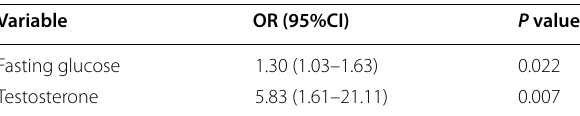
Table 4 Association of FTO rs9939609 polymorphism (AA vs. TT) with different variables in